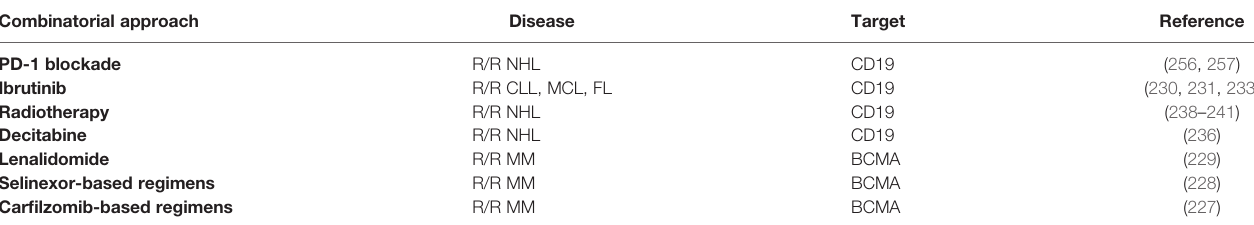
TABLE 3 | Combinatorial strategies with CAR-T cell therapy reported in clinical studies. Combinatorial approach